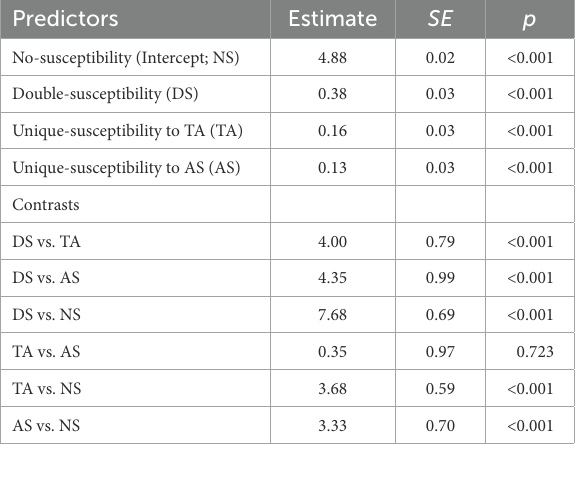
TABLE 4 Standardized coefficient estimates of the LME model predicting state anxiety. Predictors